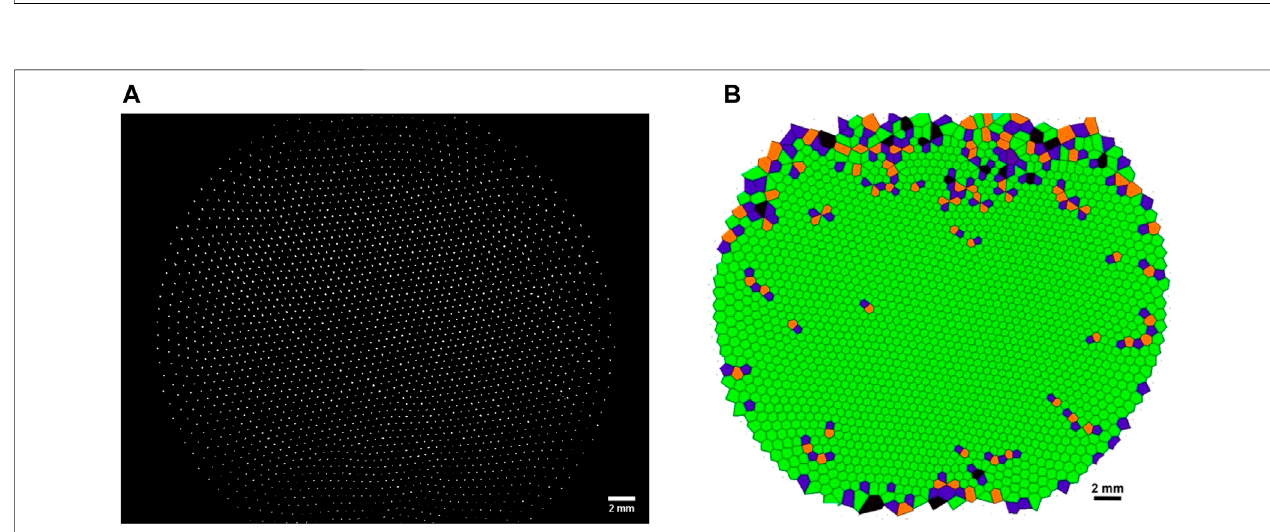
FIGURE 5 | Top-view image (A) of falling microspheres recorded when they were at a height of 0.9 mm above the lower electrode. The Voronoi diagram (B) of the microspherearrangementsjustbeforeimpactontheelectrodeisnotmuchdifferentfromthatwhentheplasmawason,asseenin Figure4B .Thisresemblancecon fi rms that the crystalline structure of the cloud of microspheres was largely preserved as it